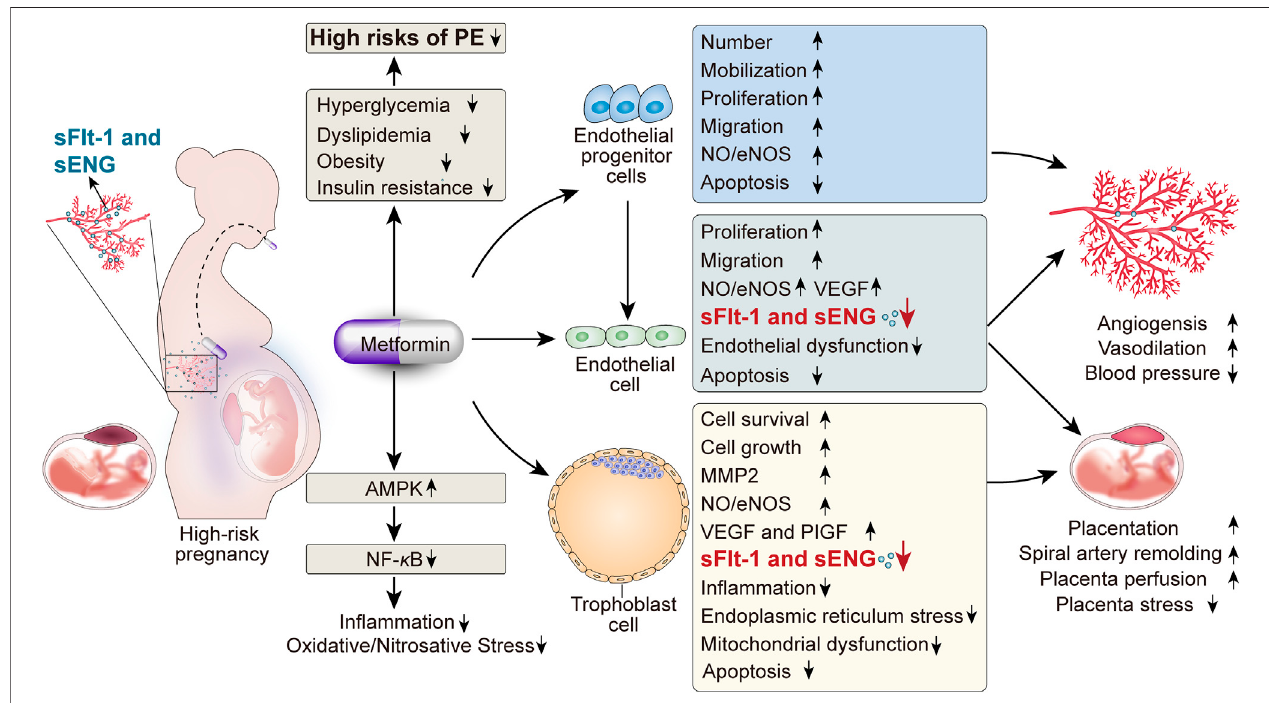
FIGURE 2 | Bene fi cial pleiotropic effects of MET on PE and the potential mechanisms.